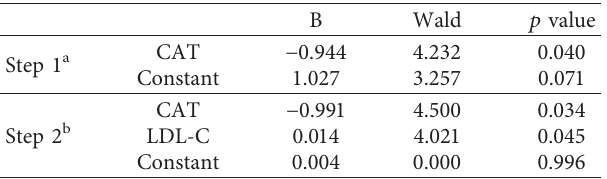
Table 9: Prediction of the crisis state considering antioxidant and lipid parameters in the final model logistic regression.